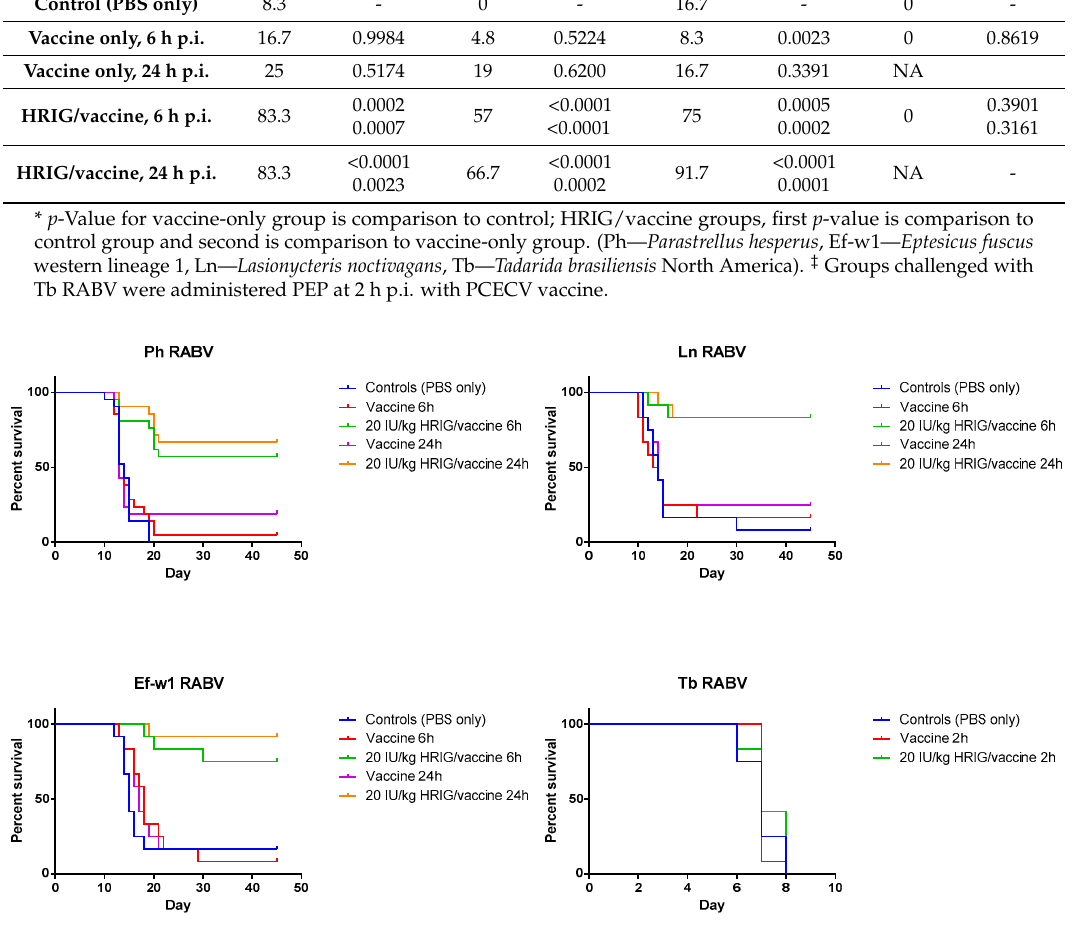
Figure 2. Validation of model and PEP initiation—Kaplan-Meier survival curves for Syrian hamsters after infection with bat rabies viruses. Hamsters ( n = 12 or 21 per group) infected with the indicated RABV isolate 2, 6, or 24 h prior to intervention, received PEP consisting of either vaccine only (HDCV or PCECV) or vaccine in combination with 20 IU/kg HRIG. Table 2. Validation of animal model and postexposure prophylaxis (PEP) initiation ( p -values based on log-rank Mantel-Cox test, comparing CL184 with standard PEP regimen 20IU/kg HRIG/vaccine).